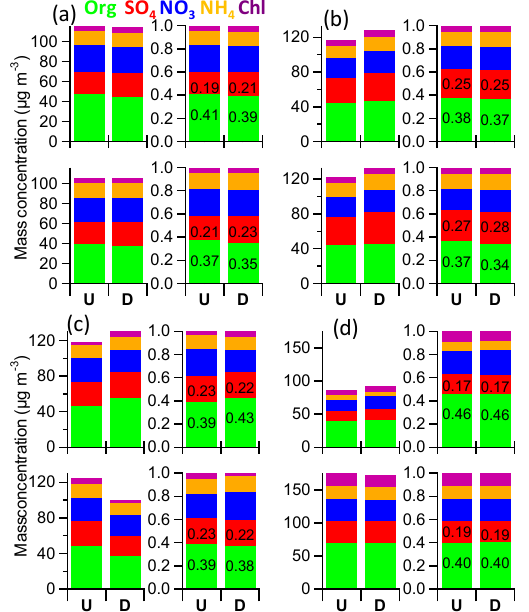
Figure 5. Average chemical composition of NR-PM 1 for selected vertical profiles: (a) V24, (b) V29, (c) V33, and (d) V14 at ground level (c, d) and 260m (a, b) . The numbers on bar charts are the mass fractions of sulfate and organics. “U” and “D” represent “up” and “down” experiment, respectively.